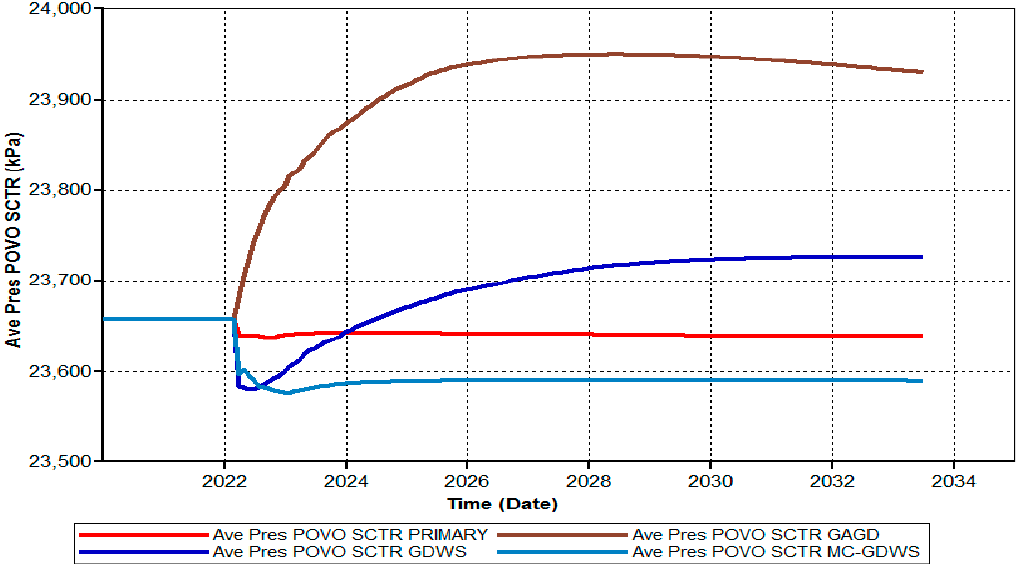
Figure 8. Average reservoir pressure expressed by year for the TC-GDWS-AGD, GDWS-AGD, GAGD, and primary (base-case) PUNQ-S3 simulations.